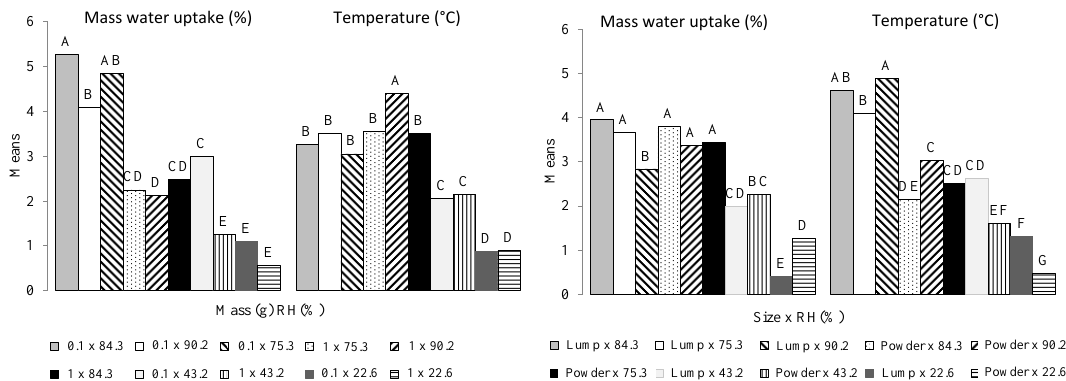
Figure 7. Second order interactions multiple comparisons according to the Tukey test. The means with the same letter were not significantly different at 5% (α = 0.05). Lump = piece.